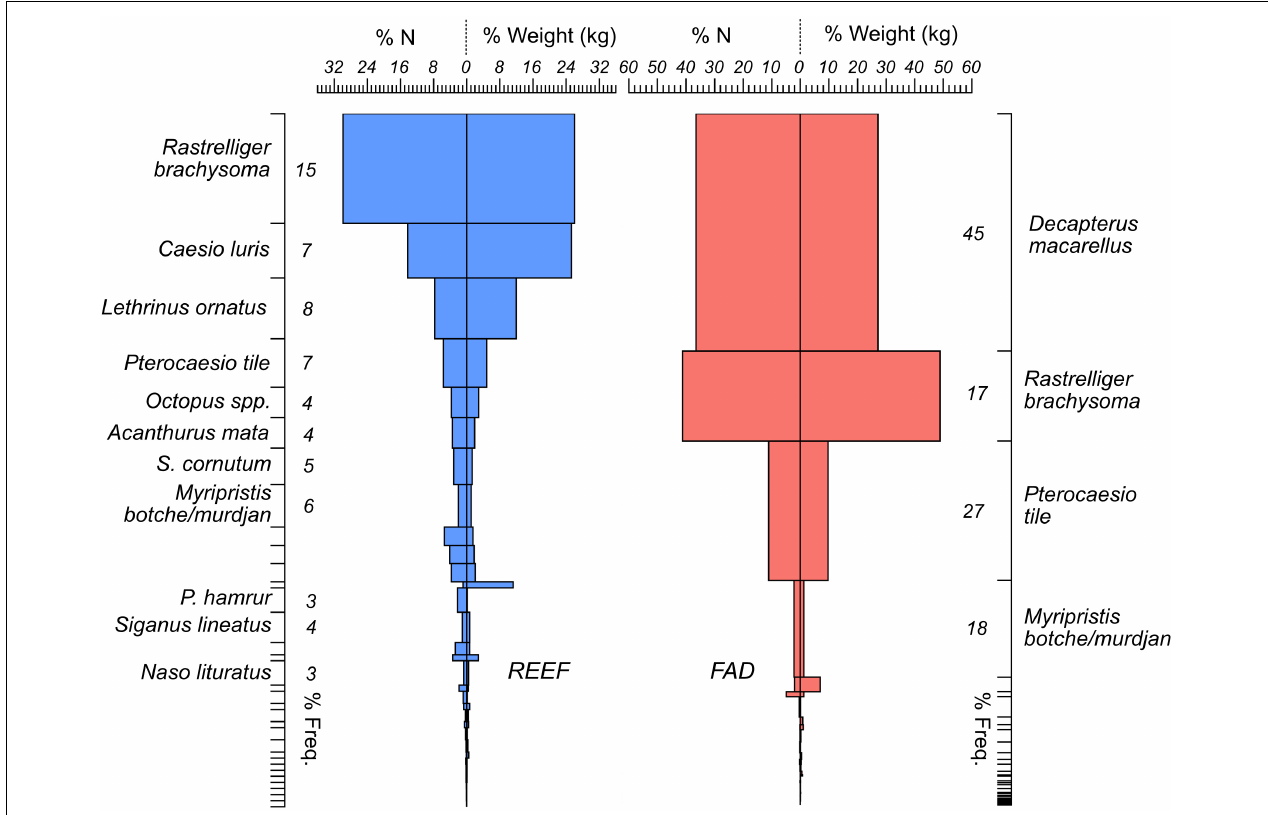
FIGURE 4 | Catch composition for small-scale fisheries landings from reef and FAD fishing from Adara, Atauro Island, Timor-Leste. The size of the box represents the %IRI of each species in each location, where % N is the proportion of total individuals, %Freq is the proportion of total samples, and %Weight is the proportion of total weight